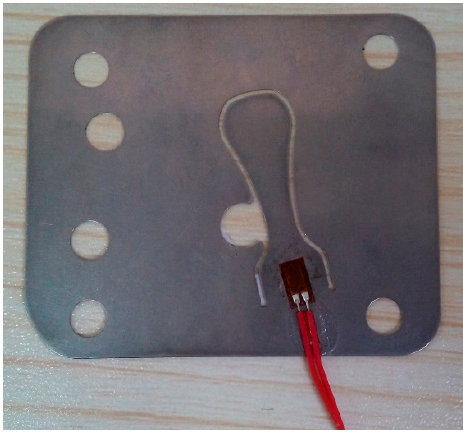
Figure 4. Schematic of the strain gauge installation.